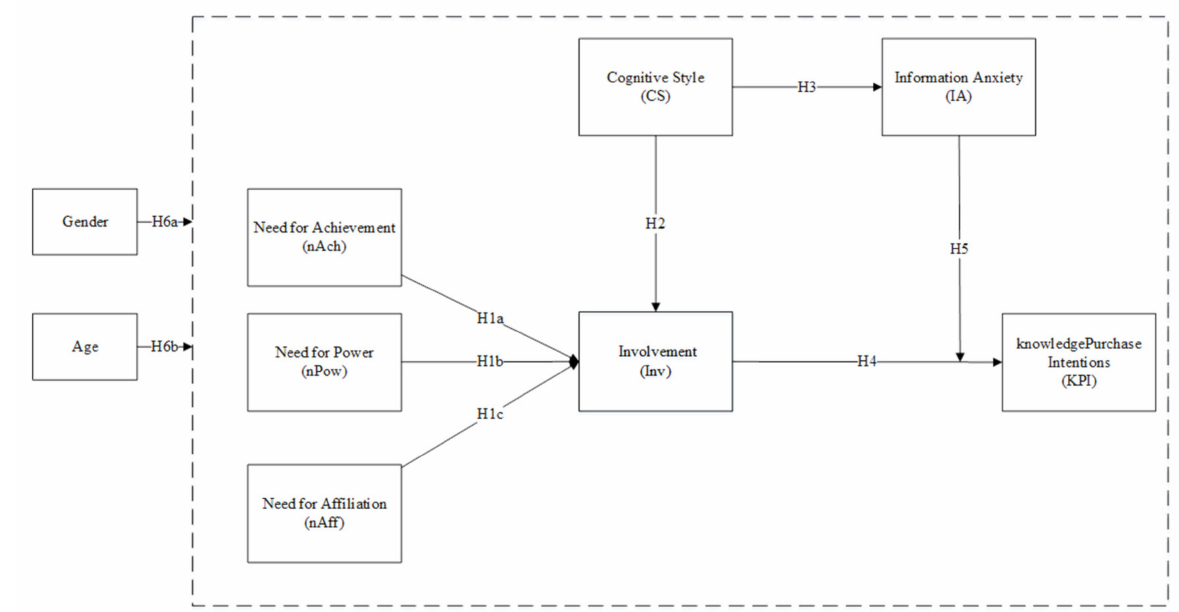
Figure 2. Research model of the demand to knowledge payment